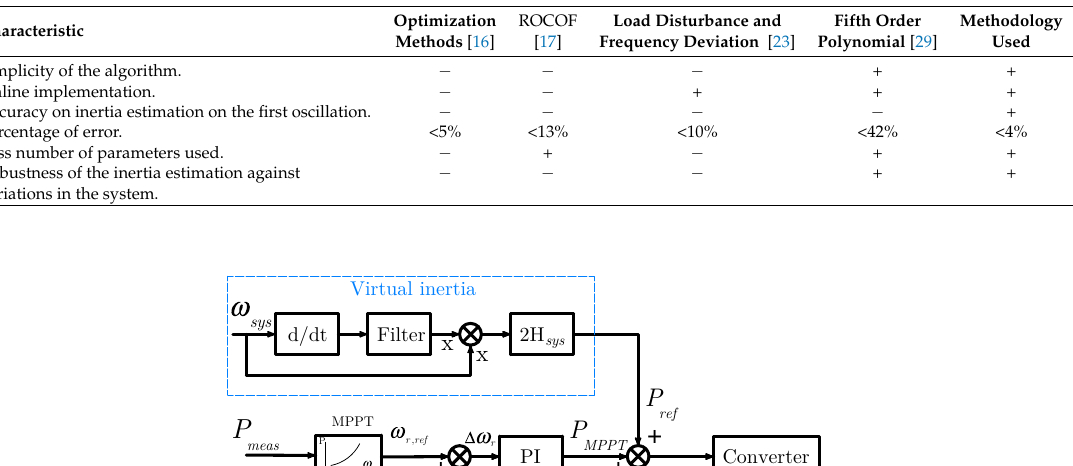
Table 1. Comparison among methodologies for the inertia estimation.